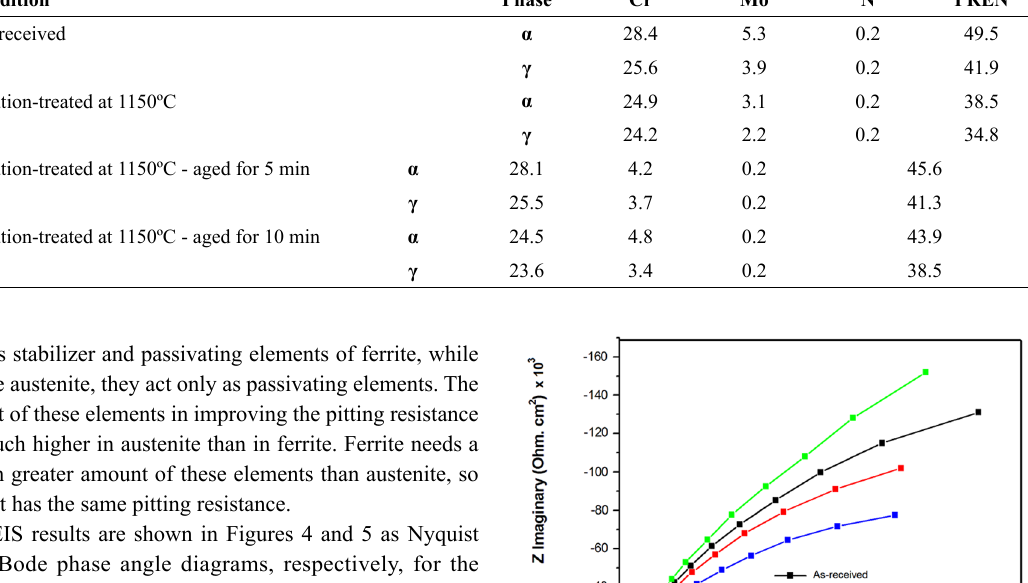
Table 5. Pitting resistance equivalent number (PREN) of ferrite and austenite phases Condition